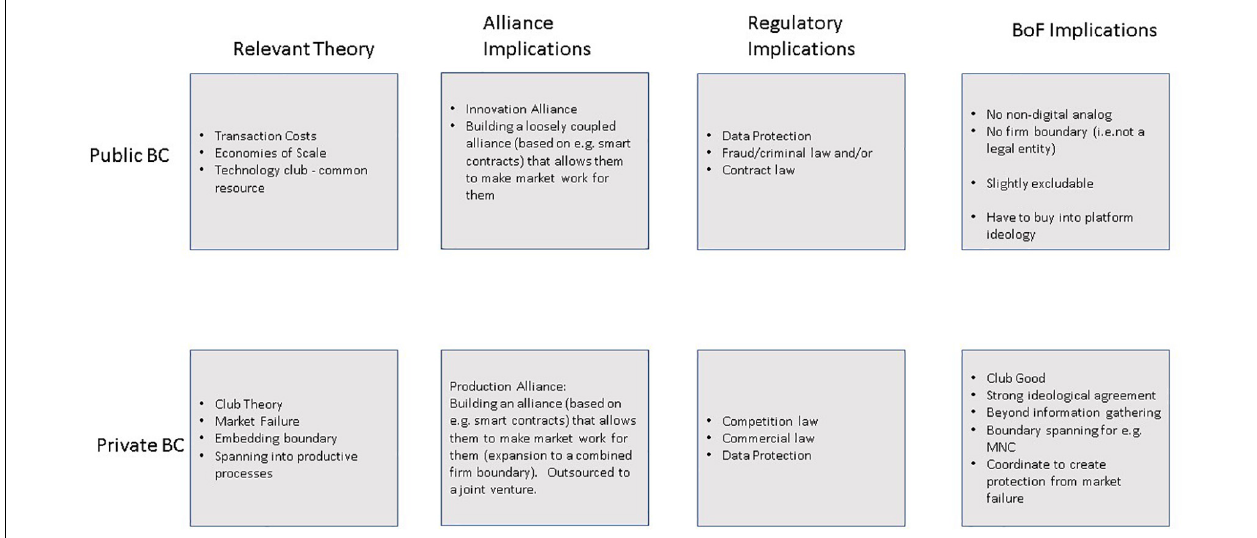
FIGURE 3 | Policy and economic implications of different blockchain